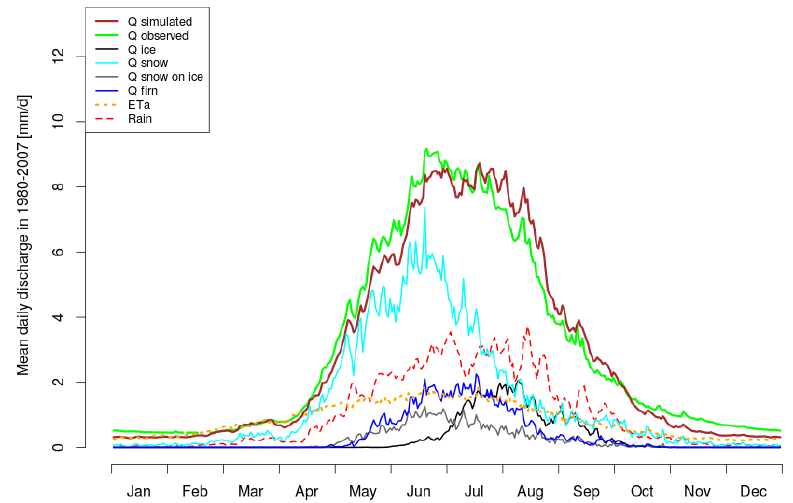
Figure 4. Mean daily simulated and observed streamflow for the Brunau catchment during the period 1980–2007, its most important simulated components and simulated ETa.